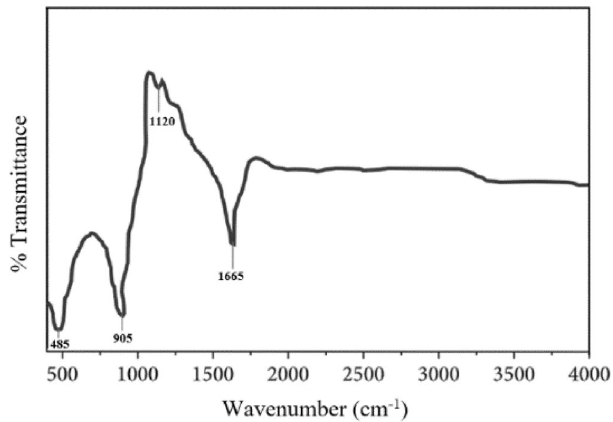
Figure 4. FTIR spectroscopy graph of MoS 2 nanoparticle.